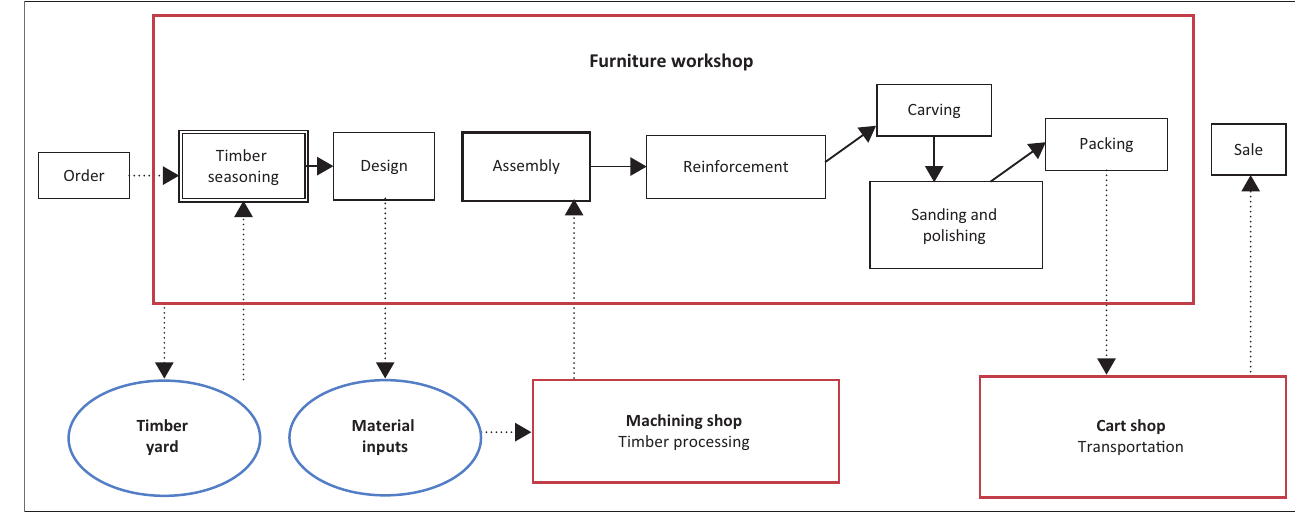
Note: Solid lines represent activities carried out by furniture workshops. Dotted lines represent outsourcing activities. FIGURE 2: Integrated production